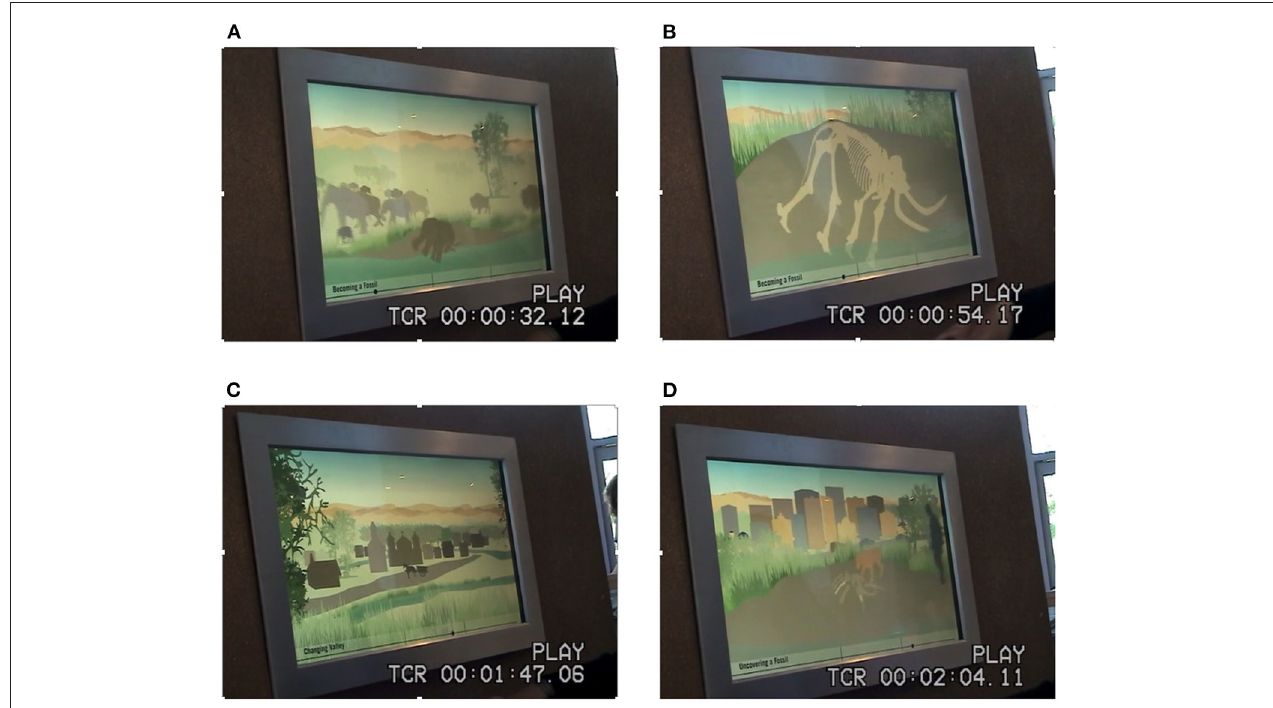
FIGURE 2 | (A–D) Screenshots of the Spin Browser, showing (A) an early frame in the section on “Becoming a Fossil,” (B) a later frame in the section on “Becoming a Fossil,” (C) a frame from the section on “Changing Valley,” and (D) a frame in the section on “Uncovering a